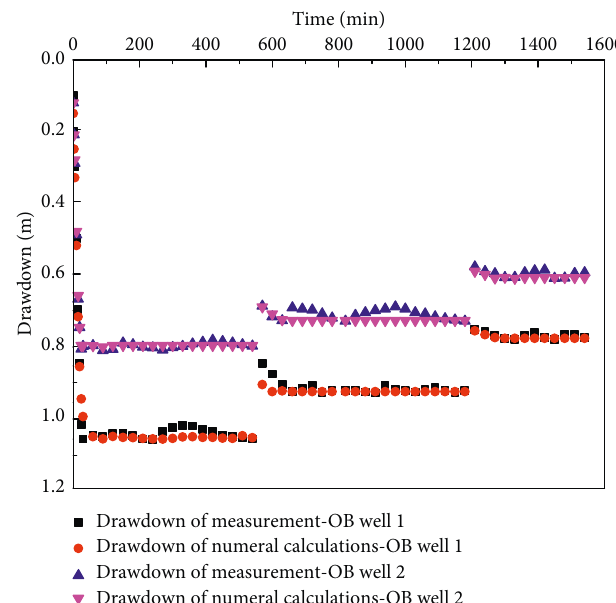
Figure 9: Change in water level in observation well 1 and well 2.